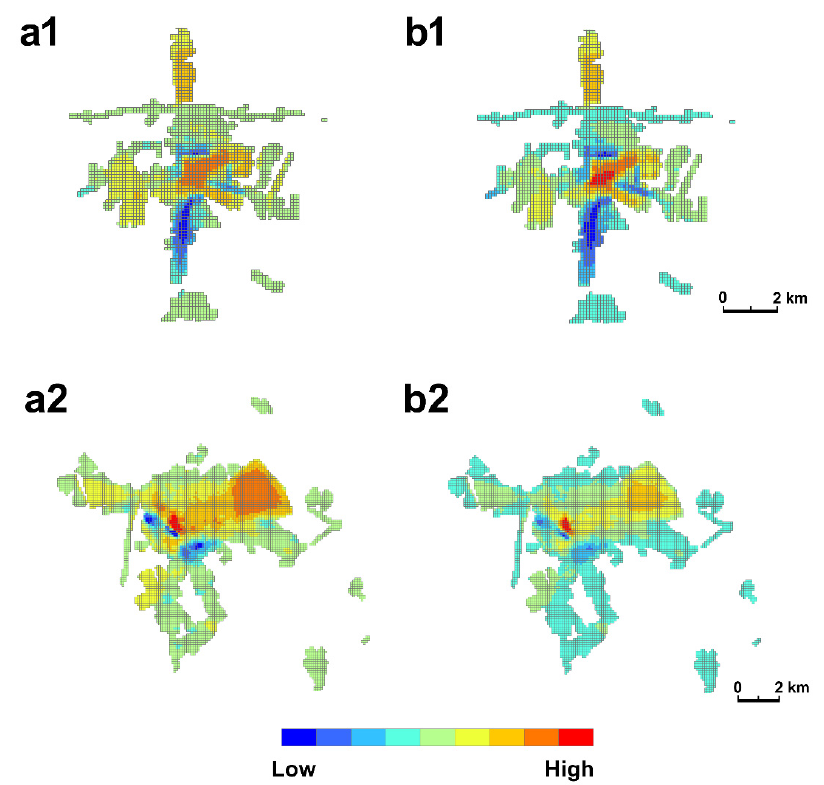
Figure 4. Local differences of place judgment: (a ) local counts of marking a place safe minus local counts of marking it unsafe; ( b ) normalized number of marking a place safe minus normalized number of marking it unsafe. Higher values indicate safer, lower values indicate more unsafe perception. Example city: ( 1 ) Nagykanizsa, ( 2 ) Székesfehérvár.